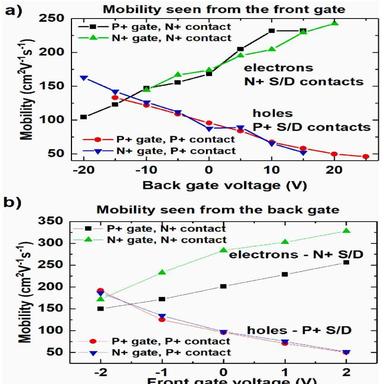
Extracted mobility from devices with P + or N + source/drain contacts and P + or N + poly-Si gate as seen from the a) front-gate b) back-gate.